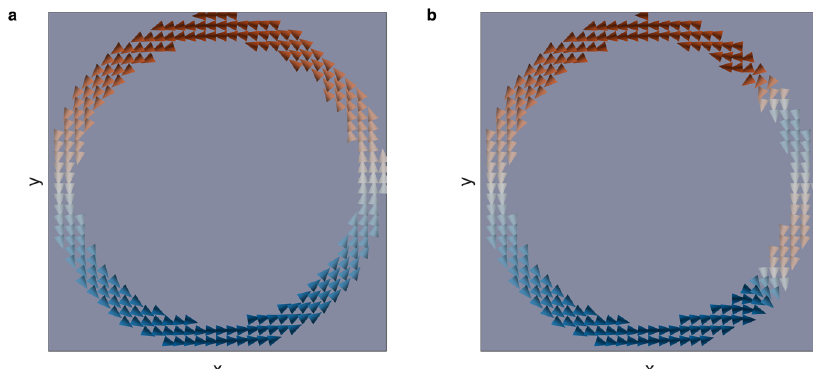
Fig. 2 The magnetic con fi gurations. Stabilized a ground state and b 2DW (domain wall) state utilizing a tiered energy minimization. The in-plane magnetization component is shown by cones and colored by the m x value (see Supplementary Movies 1 and 2).